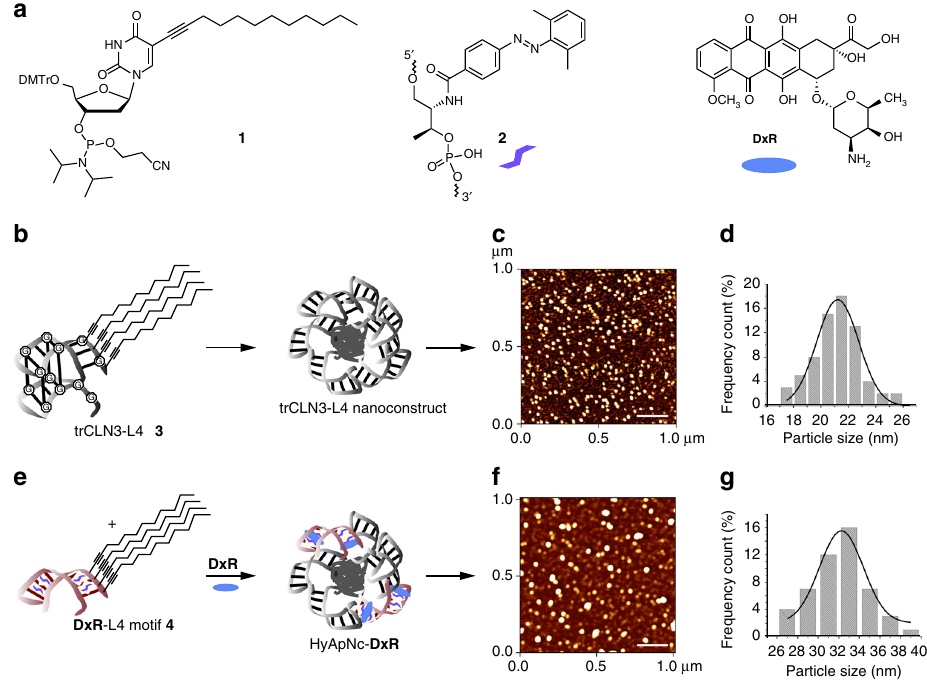
Fig. 1 Assembly and characterization of the photo-switchable aptameric nanoconstruct. a Structures of the lipid-functionalized dU-phosphoramidite 1 , the 2 ′ ,6 ′ -dimethylazobenzene-D-threoninol residue 2 , and doxorubicin DxR . b The lipid-functionalized anti-cMet aptamer trCLN3-L4 3 and its self-assembly into the corresponding trCLN3-L4 nanoconstruct. c AFM images of the trCLN3-L4 3 nanoconstruct shows its size and morphology. Scale bar: 200 nm. d Size distribution of the trCLN3-L4 3 nanoconstructs. e The lipid-functionalized DxR -carrier hairpin motif DxR -L4 4 modi fi ed with 2 ′ ,6 ′ -dimethylazobenzene 2 (purple), and the self-assembly of 3 , 4 , and DxR (blue) to form DxR -loaded HyApNc- DxR nanoconstruct. f AFM images of the HyApNc- DxR nanoconstruct shows its size and morphology. Scale bar: 200 nm. g Size distribution of the HyApNc- DxR nanoconstructs. The size distributions in d and g show that the hybrid nanoconstructs HyApNc- DxR are on average about 10 nm larger than the homogeneous trCLN3-L4